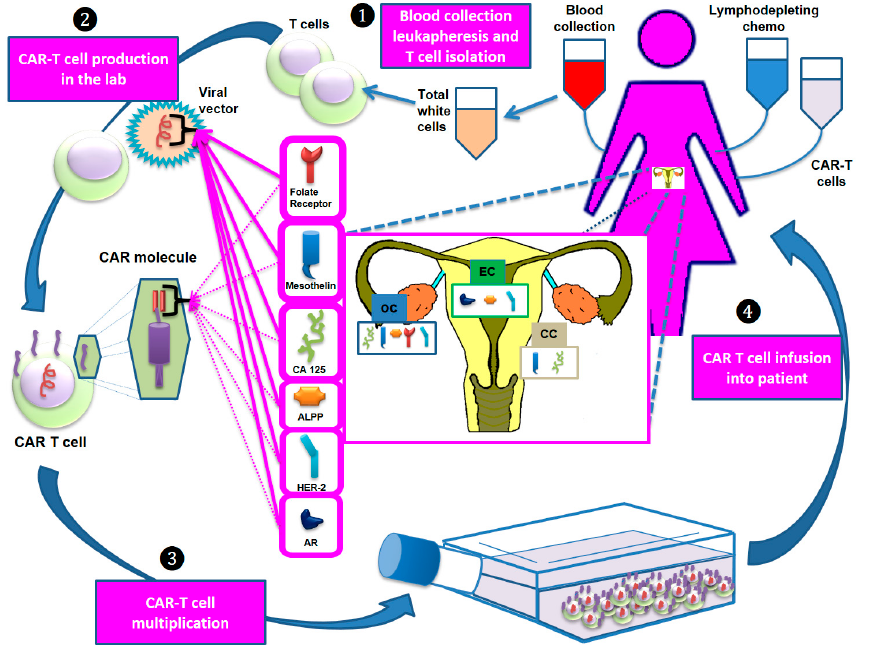
Figure 1. The main steps of the development of CAR-T cell therapy. Step 1: T cells are collected via apheresis. Step 2: The collected T cells are sent to a laboratory and genetically engineered by introducing specific DNA genes through a viral vector to produce CARs on the T cell surface. These molecules are designed to bind specific antigens (e.g., mesothelin, CA125) that recognize and destroy the tumor cells expressing them. Step 3: The re-engineered CAR-T cells are multiplied, frozen and (Step 4) reinfused into the patient. Before reinfusion, lymphodepleting chemotherapy is administered. Abbreviations: ALPP: placental alkaline phosphatase; AR: androgen receptor; CC: cervical